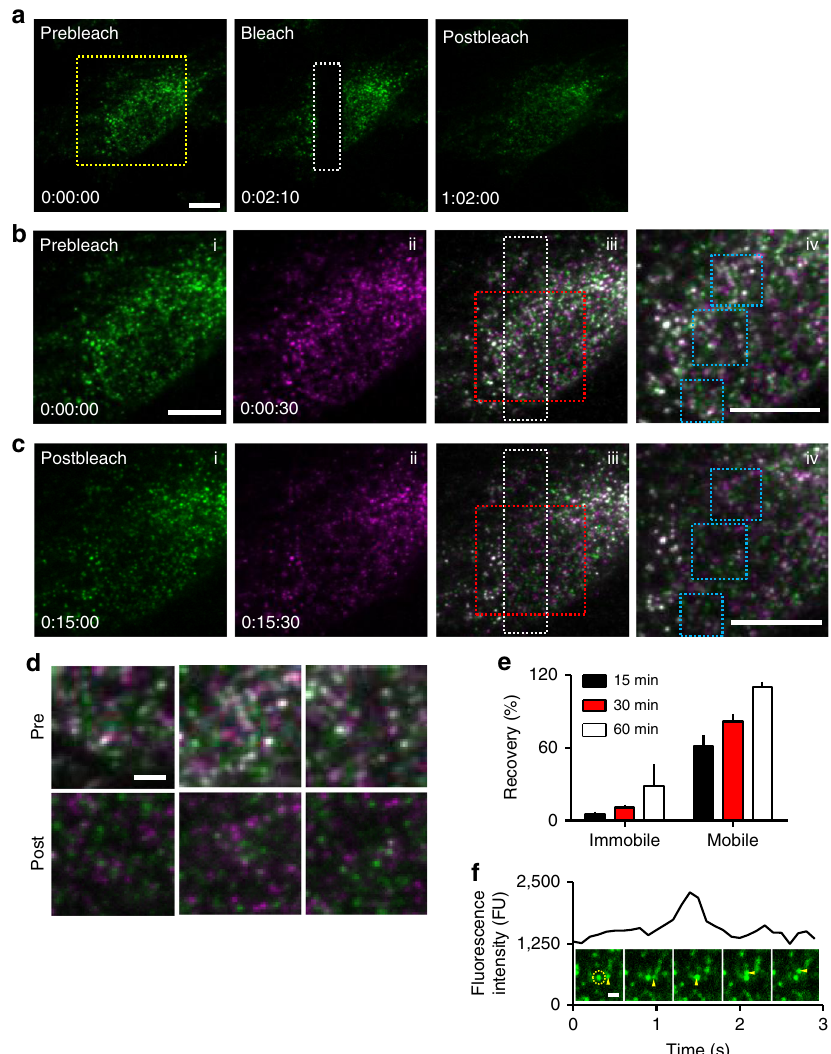
Fig. 3 IP 3 Rs within mobile puncta do not exchange with immobile puncta. a TIRFM images of FRAP experiment show images before, immediately after and 60 min after bleaching. Bleached area shown by white rectangle. Times shown as h:min:s. b , c Enlarged images of yellow boxed area in a . Immobile puncta were identi fi ed by overlaying two frames (30 s apart) using pseudocolours for each (green and magenta), such that immobile puncta appear white in the overlay (iii, iv) (Supplementary Fig. 7). Images were captured before photobleaching ( b ) and after recovery for 15 min ( c ). Enlarged areas (red boxes in iii) are shown in (iv). Scale bars ( a – c ) = 10 µ m. d Enlargements (blue boxes in b iv and c iv) show images before and 15 min after bleaching. Scale bar = 2 µ m. Abundant green and magenta puncta in the post-bleach images ( c , and lower in d ) indicate rapid exchange of mobile EGFP-IP 3 R, while the scarcity of white puncta suggests very slow exchange of immobile EGFP-IP 3 R1. e Summary results show fl uorescence recovery ( F / F 0 , %, mean ± SEM) from three cells (26 ± 15 immobile puncta per cell were identi fi ed in the initial images). f Example trace from a region centred on an immobile punctum (circled in fi rst image) shows stepwise increase and decrease in fl uorescence intensity as a mobile punctum (arrows) moves through the immobile punctum (Supplementary Movie 2). Scale bar = 1 μ